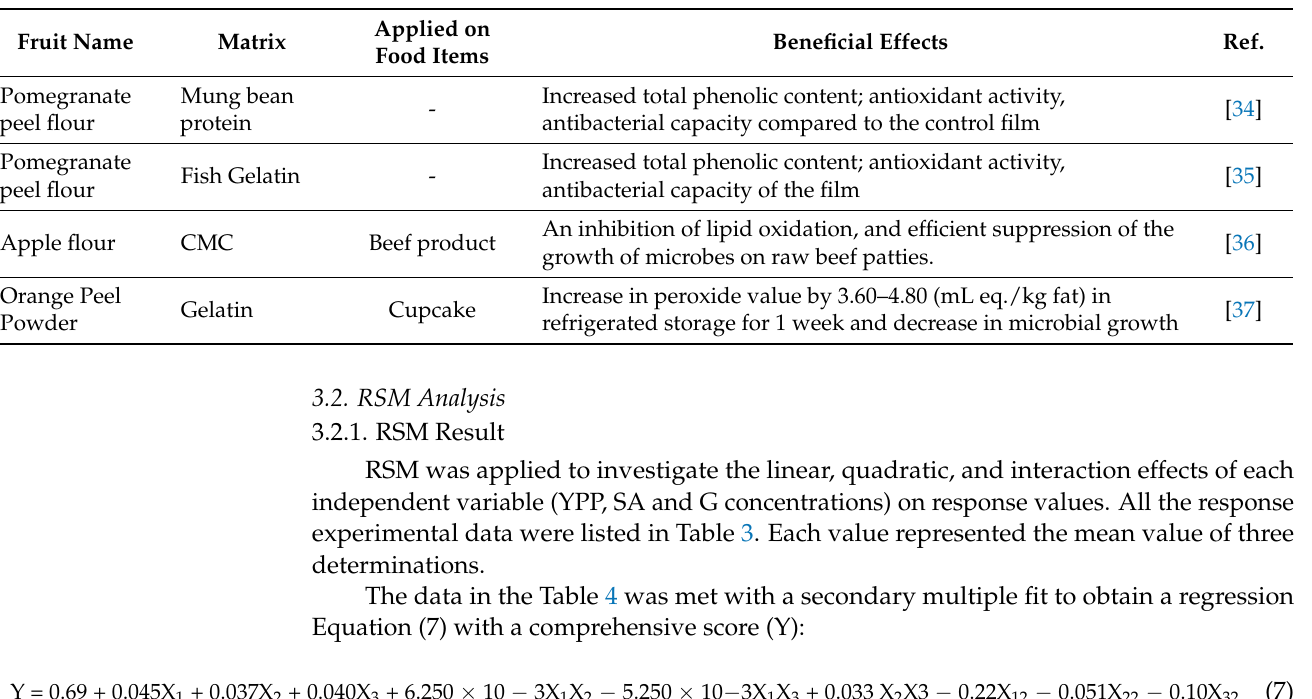
Table 3. Fruits peel based edible films with their applications.